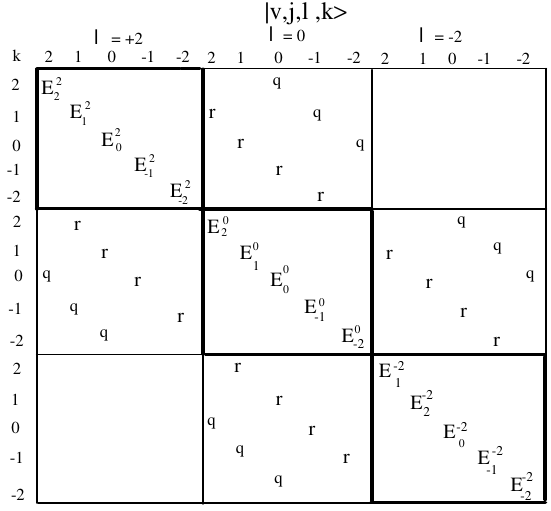
Figure 2 . The Hamiltonian matrix for v